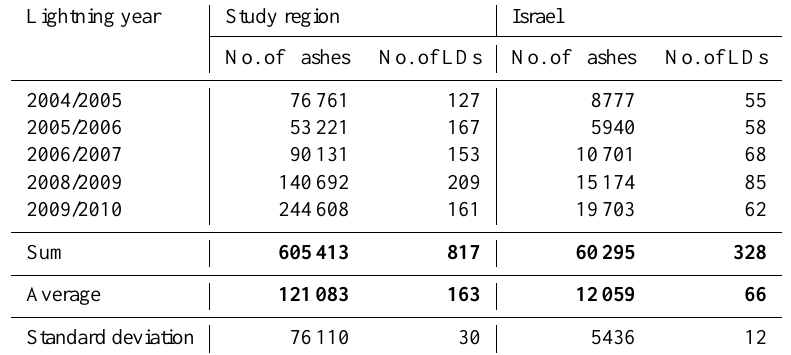
Table 1. Number of flashes and number of lightning days (LDs) for each lightning season above the study region and above Israel.